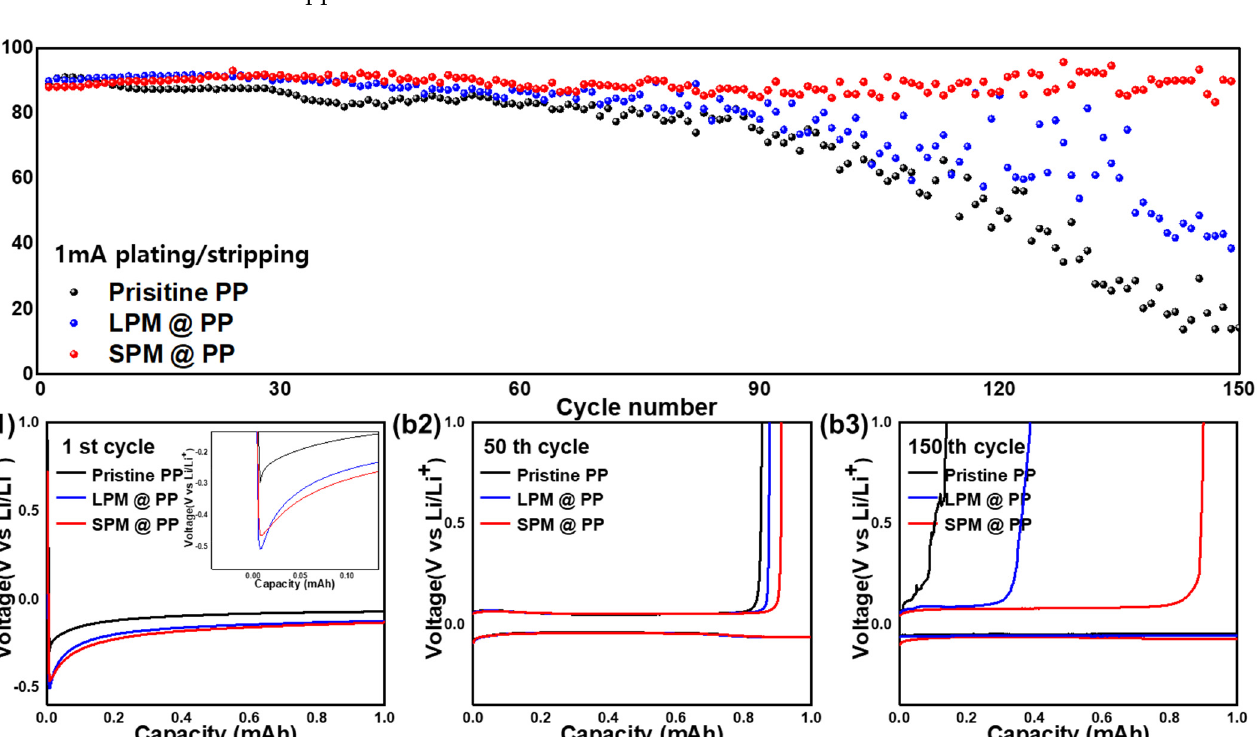
cycle performance. Figure 4b1–b3 show the voltage profiles of each Li-Cu cell at the 1st, 50th, and 150 cycles. At the initial nucleation step, the average nucleation overpotentials of Li at the cells with LPM- and SPM-coated separators are slightly higher than that of the cell with the pristine PP separator due to the covering of the pores by the PM coating layer. However, upon Li dendrite growth and the generation of a homogeneous electric field, the PM-coated separator reduced the resistance of Li deposition. Moreover, the cell with the SPM-coated separator presents clearer and longer discharge region than the cells with the pristine PP separator and LPM-coated separator at 150 cycles. These results mean that the dual role of the SPM coating layer (constructing a dense electric field and physically protecting separator) contributes to the superior electrochemical stability by the suppression of dendritic Li.